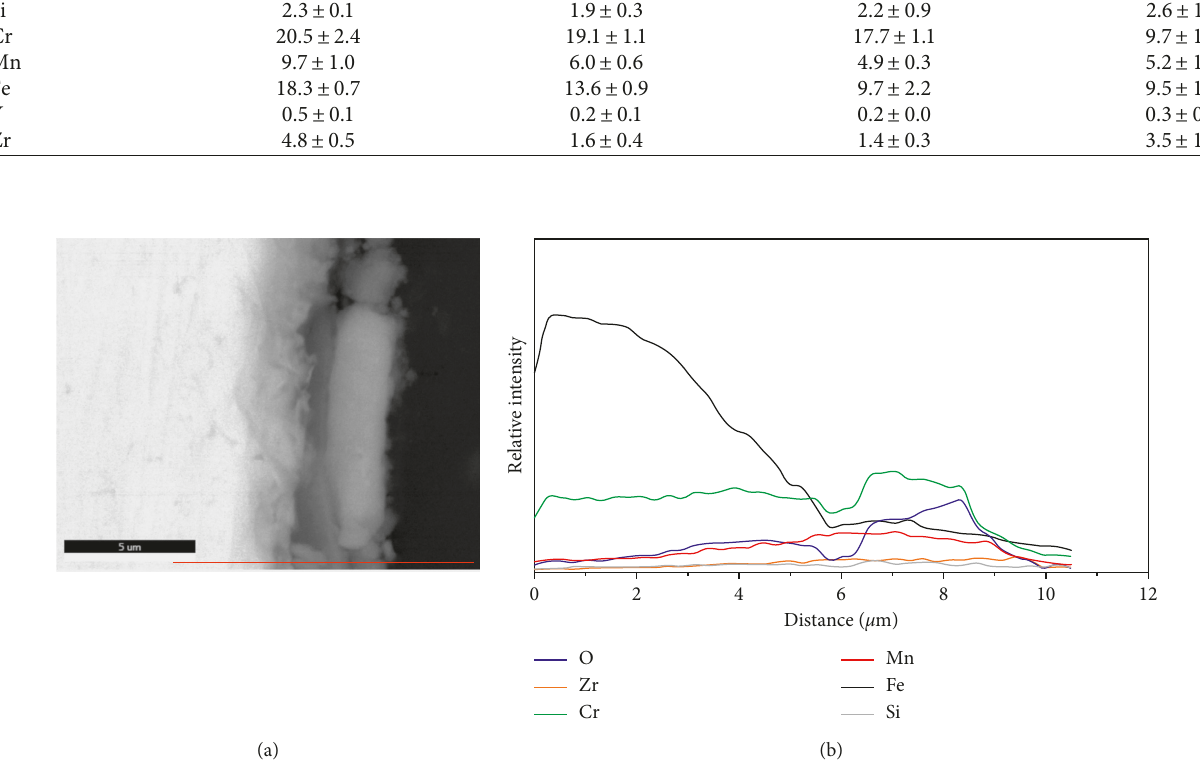
Figure 17: Line scan analysis of the cross section of the B-123 (YSZ) sample. (a) EDS spot analysis. (b) Line